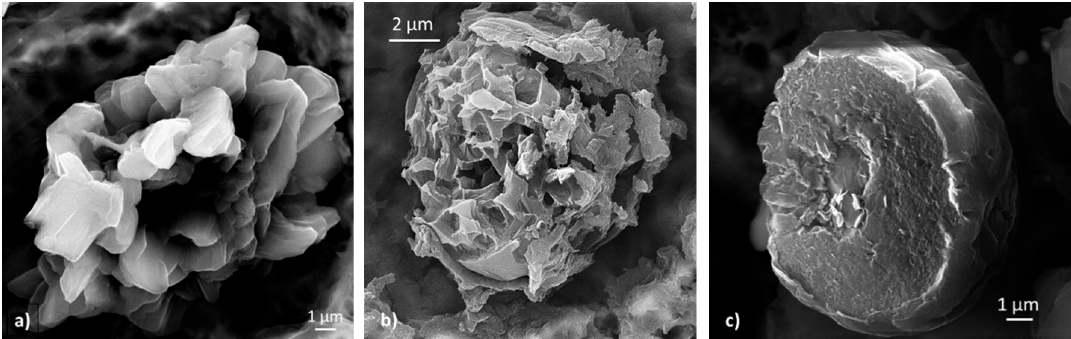
Figure 42. Graphite morphology in annealed irons with various Mg contents; ( a ) irregular graphite in no Mg iron; ( b ) skeletal-hopper graphite in 0.017% Mg iron; ( c ) hemispherical graphite in 0.047% Mg iron. See Reference [111] for experimental conditions.